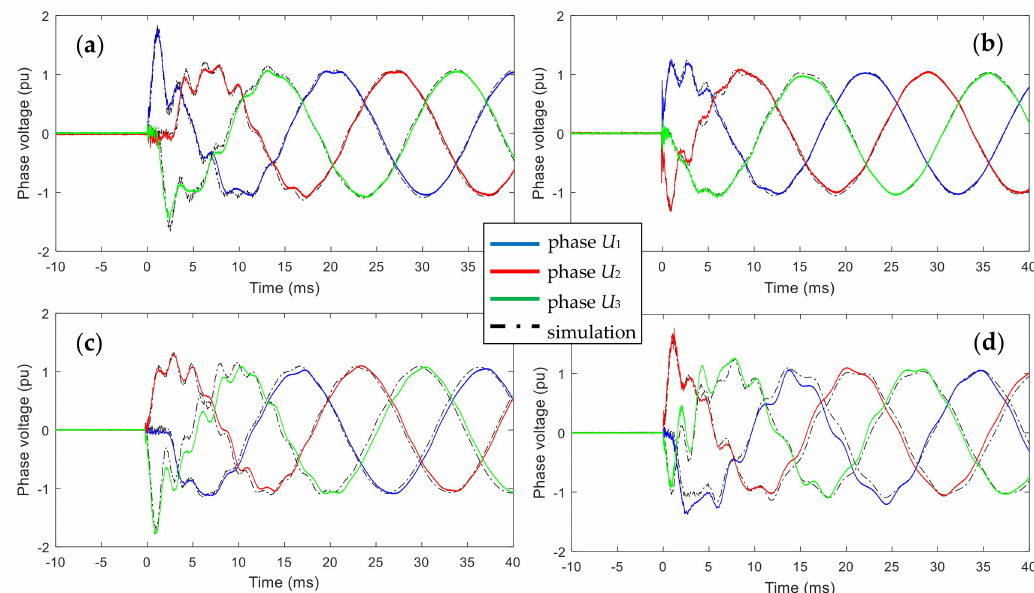
Figure 6. Comparison between D / I measurement (continuous lines in colour for the three phases) and PSCAD simulations (dash-dotted black lines). Generally, the maximum overvoltage value observed for each switching event and phase agree well with calculations for: ( a ) Recording at substation with energization from far end substation; ( b ) Recording and energization at the same substation; ( c ) Energization at substation 4.4 km from the observed transition point; ( d ) Energization from substation at 6.8 km from the observed transition